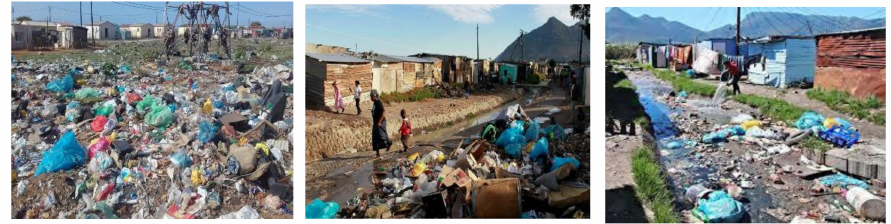
Figure 2. Random pictures of waste around townships in Port Elizabeth, Durban and